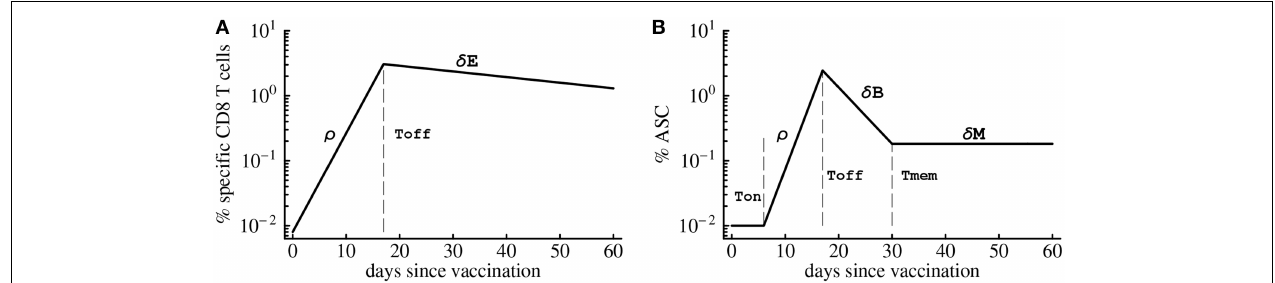
population starts expanding after the initial delay given by T on . Similarly as T cells, ASC population grows exponentially at a rate ρ until the peak, declines exponentially after the peak at a rate δ B until reaching memory phase at time T mem . Long-term loss of virus-specific ASCs is given by δ M which was set to zero in model fits due to short duration of the